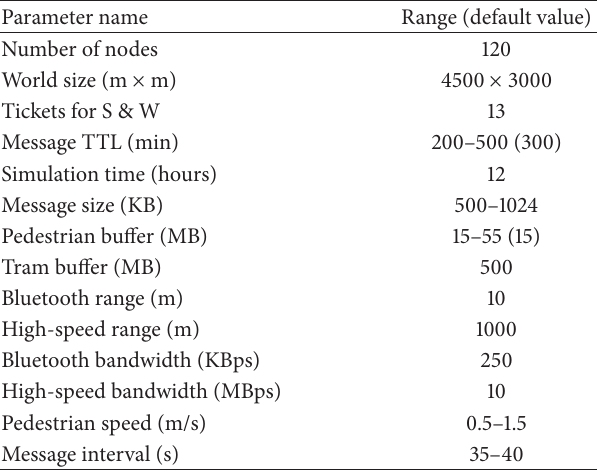
Table 3: Simulation settings of Helsinki City Scenario.